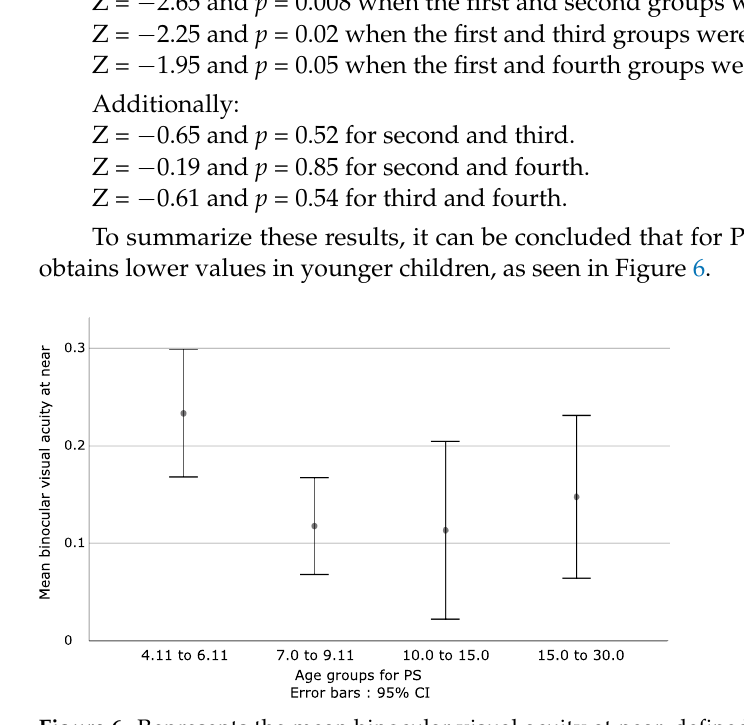
Figure 6. Represents the mean binocular visual acuity at near, defined by age groups for PS with stereopsis. What stands out is that younger children obtain lower values when compared to older ones. However, more heterogeneities for the obtained values are observed in the third and fourth groups, which are probably related to the time spent to make